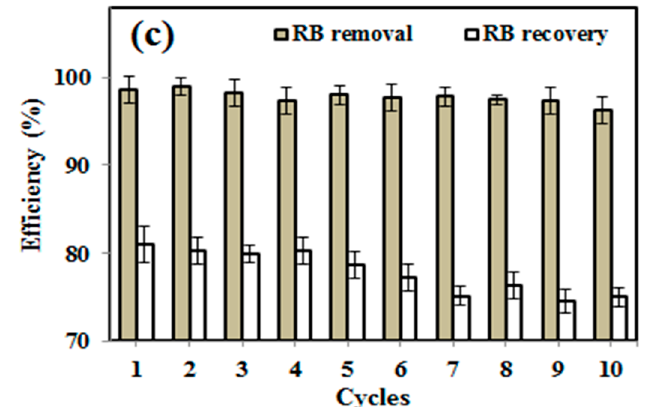
Figure 6. Using silk fibers and ZnSk composites, ( a ) RB adsorption vs. concentration and ( b ) linear plots showing the Langmuir adsorption isotherm parameters. ( c ) RB removal and recovery studies using ZnSk composites. Error bars are calculated standard deviation for three measurements.